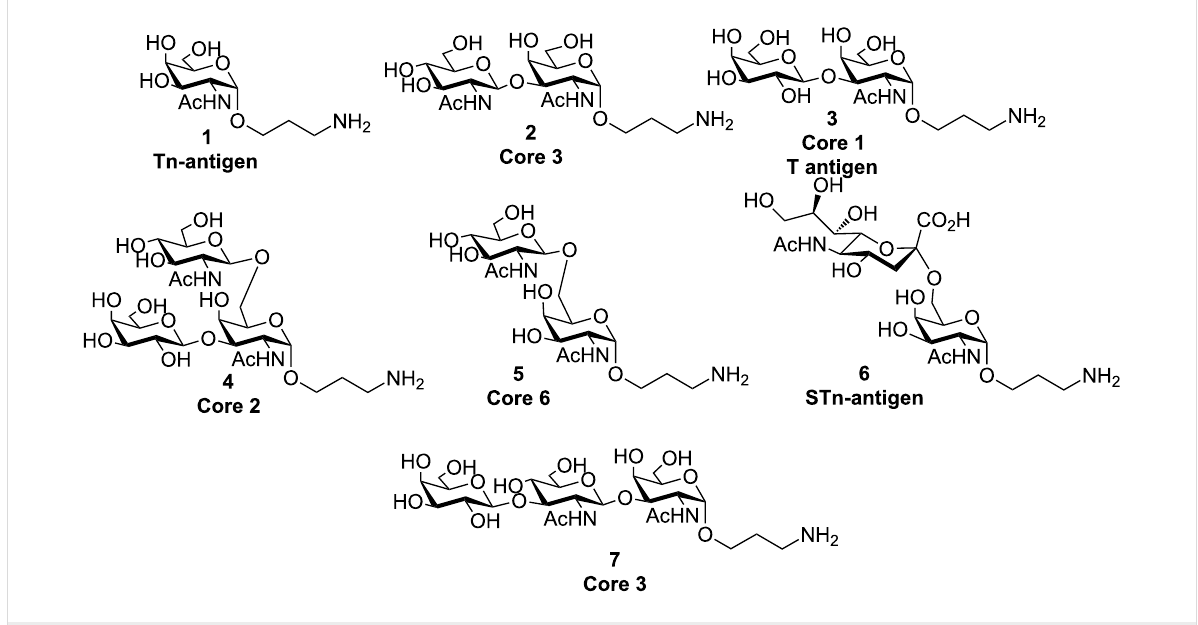
Figure 1: Structure of mucin-type oligosaccharide fragments